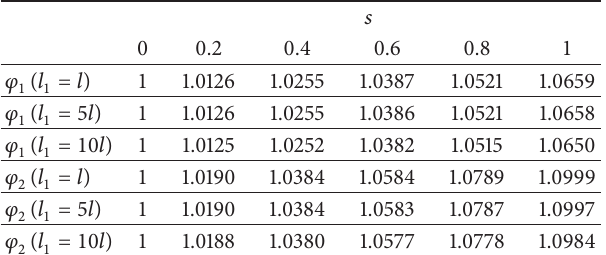
Table 4: Steady-state vibration amplitudes ratios 𝜑 1 and 𝜑 2 for different length of SWCNT, 𝑙